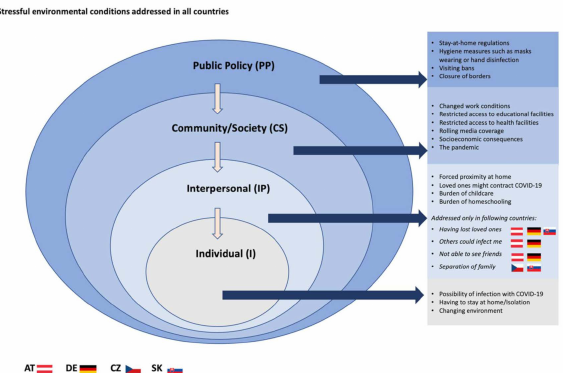
Figure 3. Stressful environmental conditions are addressed in all four countries at the public policy, community/society, interpersonal, and individual